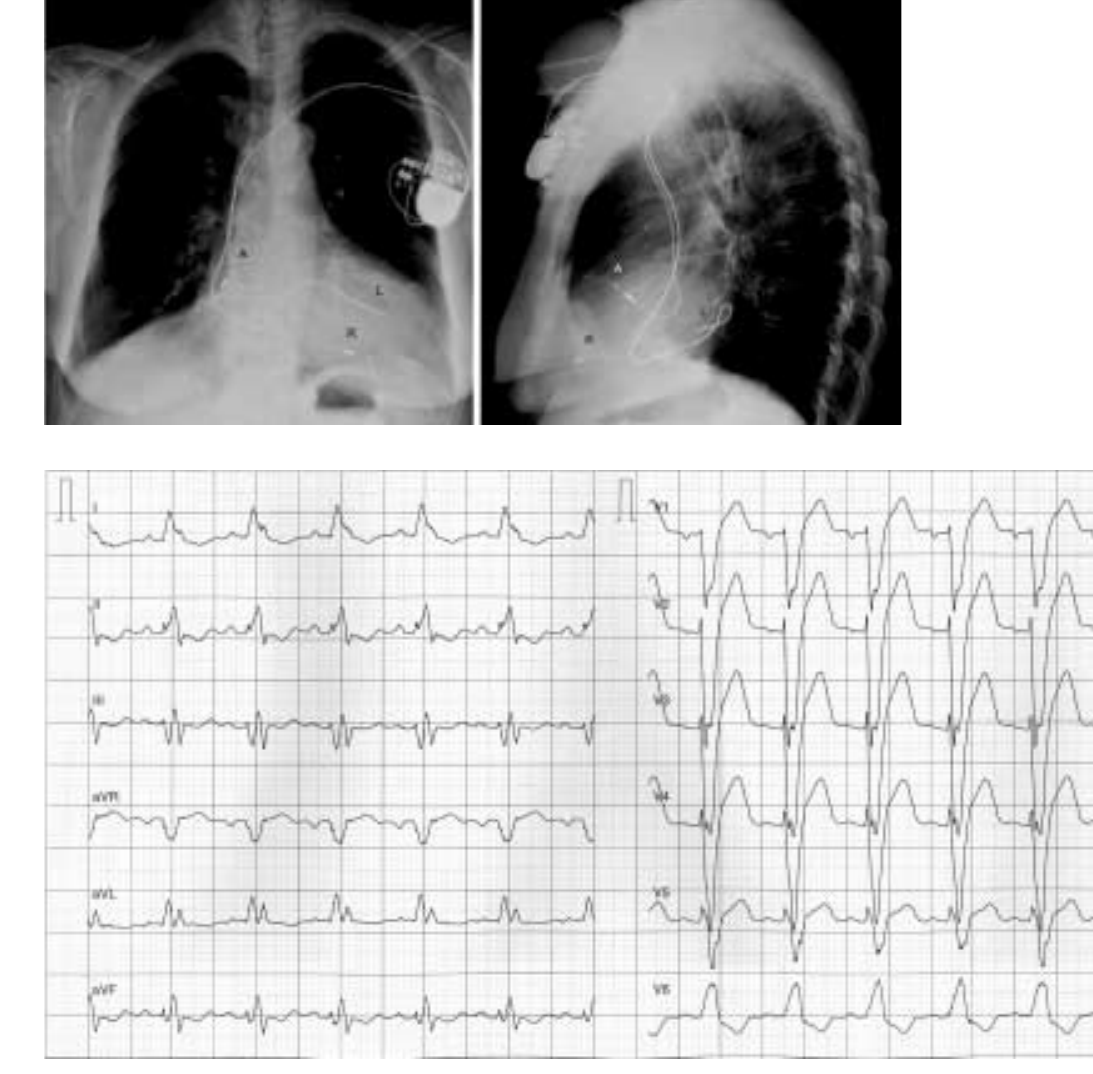
X-ray of a patient with CRT device. “A” denotes atrial, “R” right ventricular, and “L” left ventric- ular electrode.